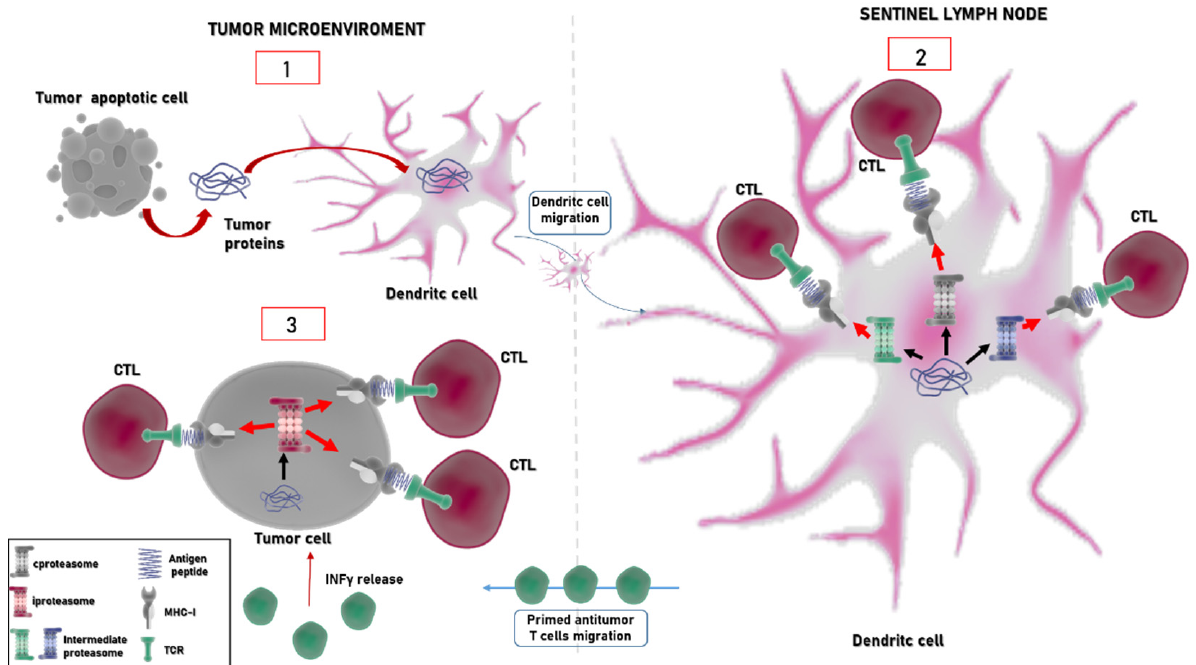
Figure 3. Activation of antitumor T cells mediated by proteasomes. At the tumor site, apoptotic cells release tumor proteins which are internalized by dendritic cells (1). These cells migrate to the sentinel lymph node, where peptides are derived by proteasome (mainly constitutive (in grey) and intermediate proteasome (in green and in blue) particles). Different populations of proteasome are represented with different colors in the figure, as indicated also in the legend. Degradation of tumor-associated proteins is presented to naïve T cells in complex with MHC-I molecules (2). Primed T cells migrate to the tumor site (3). The in loco production of IFN γ induces the expression of i26S (in red) which becomes the prevalent form of proteasome in the “hot tumor site”. Thus, tumor cells with a high content of immunoproteasome change their antigenic peptide repertoire, which can be targeted by other circulating T cells.